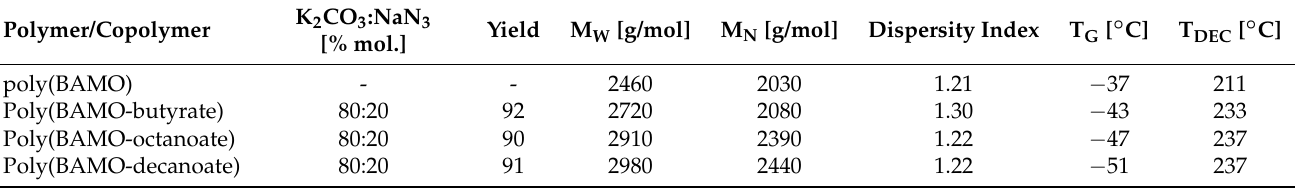
Table 3. Parameters detailing the composition of poly(BAMO) and carboxylated BAMO copolymers reported in [63], as well as their fundamental thermal properties.